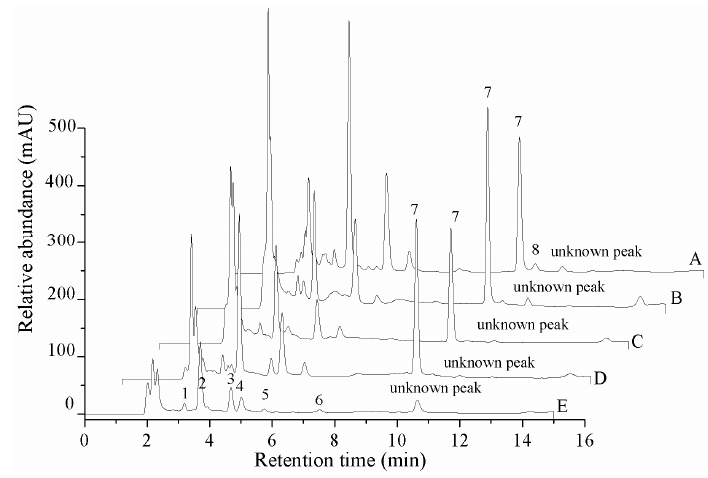
Figure 2. HPLC profile of the extraction of the nucleosides and nucleobases of O. xuefengensis . A. Cultured mycelium; B. Cultured stroma; C. Cultured coremium; D. Natural fruit body; E. Cadaver of phassus nodus . 1. Uracil; 2. Uridine; 3. Inosine; 4. Guanosine; 5. Adenine; 6. Thymidine; 7. Adenosine; 8. 2-deoxyadenosine. Table 3. Contents (mg/kg) of nine nucleosides and nucleobases in different tissues of O. xuefengensis. Natural Fruit Cadaver of Phasus Cultured Cultured Analyte Body Nodus Mycelium Stroma